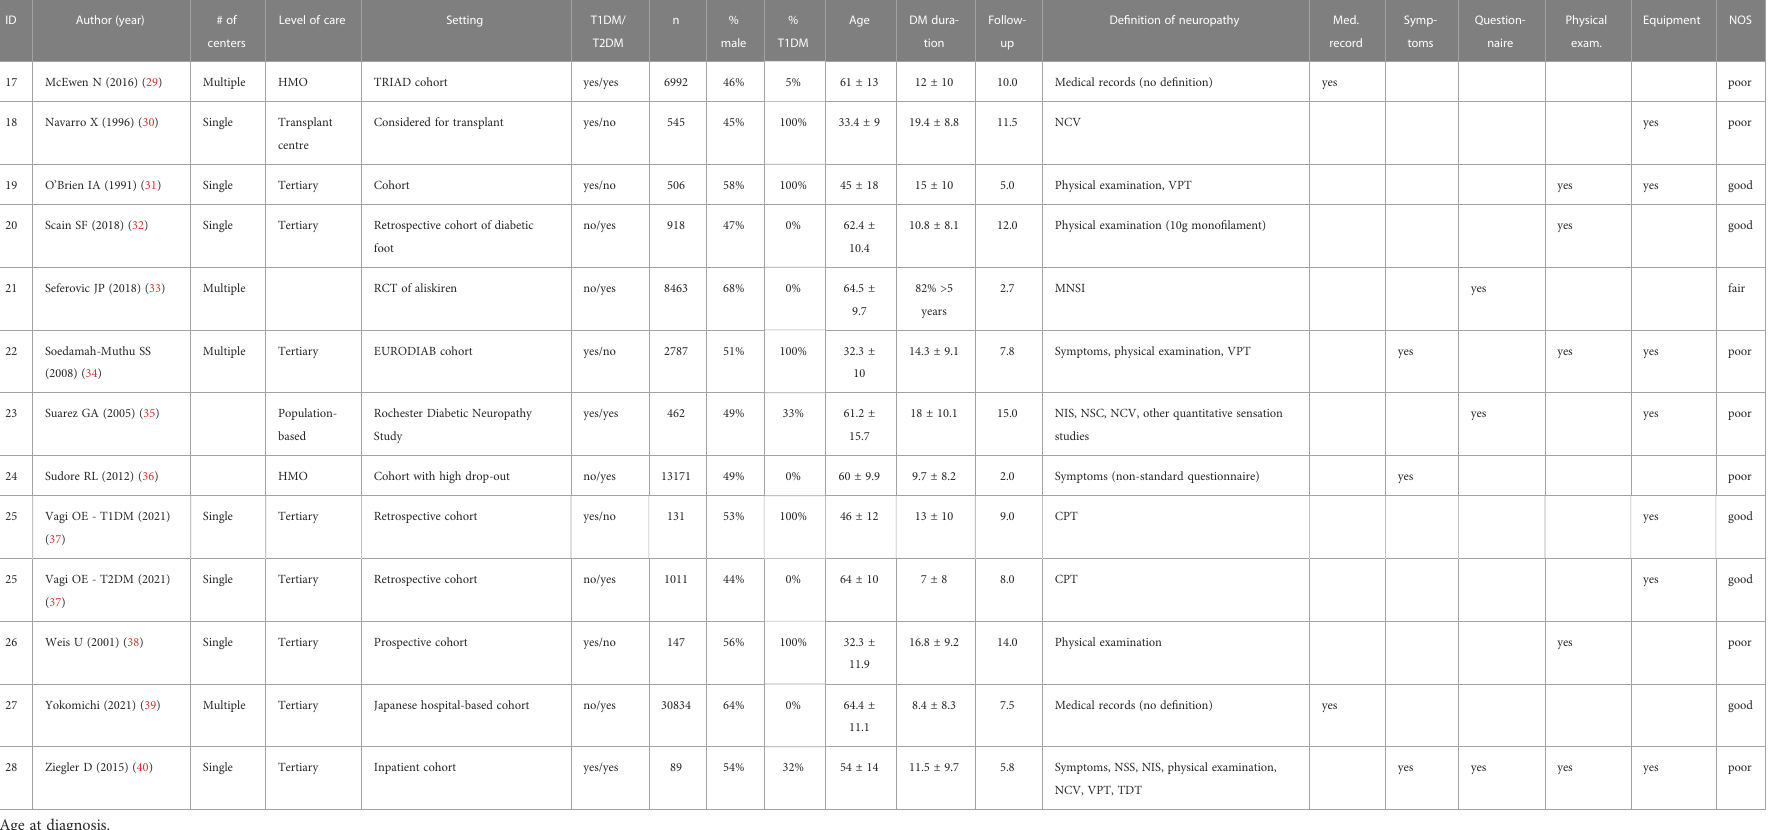
Ziegler D (2015) (40) Single Tertiary Inpatient cohort yes/yes 89 54% 32% 54 ± 14 11.5± 9.7 5.8 Symptoms, NSS,NIS, physical examination, *Age at diagnosis. Age, DM duration, Follow-up reported in years. Mean±SD. Questionnaires: MNSI, Michigan Neuropathy Screening Instrument; NIS, Neuropathy Impairment Score; NSC, Neuropathy Symptoms and Change Score; NSS, Neuropathy Symptom Score. Equipment-based methods: NCV, Nerve Conduction Velocity; TDT, Thermal Discrimination Threshold; VPT, Vibration Perception Threshold; CPT, Current Perception Threshold. ACCORD, Action to Control Cardiovascular Risk in Diabetes trial; ACCORDION, ACCORD Follow-On study; ADDITION, Anglo-Danish-Dutch Study of Intensive Treatment in People With Screen-Detected Diabetes in Primary Care; CPT, Current Perception Threshold. DD2, Danish Centre for Strategic Research in Type 2 Diabetes; DM, diabetes mellitus; ETDRS, Early Treatment Diabetic Retinopathy Study; HMO, Health Maintenance Organization; Look AHEAD, Look AHEAD (Action for Health in Diabetes) study; Med. Record, medical record; MNSI, Michigan Neuropathy Screening Instrument; NCV, Nerve Conduction Velocity; NIS, Neuropathy Impairment Score; NOS, Newcastle-Ottawa Scale; NR, not reported; NSC, Neuropathy Symptoms and Change Score; NSS, Neuropathy Symptom Score; T1DM, type 1 diabetes mellitus; T2DM, type 2 diabetes mellitus; TDT, Thermal Discrimination Threshold; TRIAD, Translating Research Into Action for Diabetes study; VPT, Vibration Perception